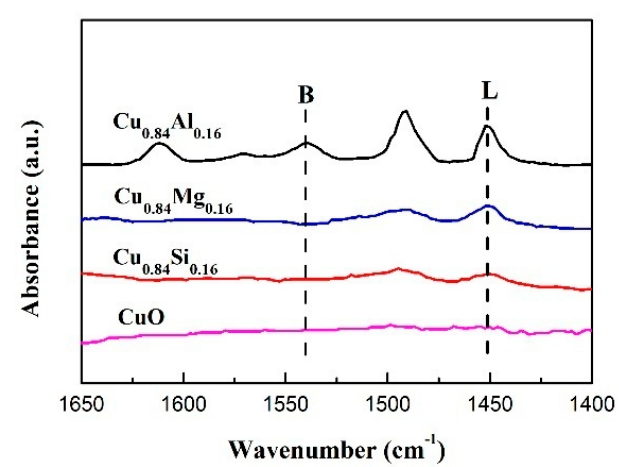
Figure 6. NH 3 -TPD profiles of the catalysts.